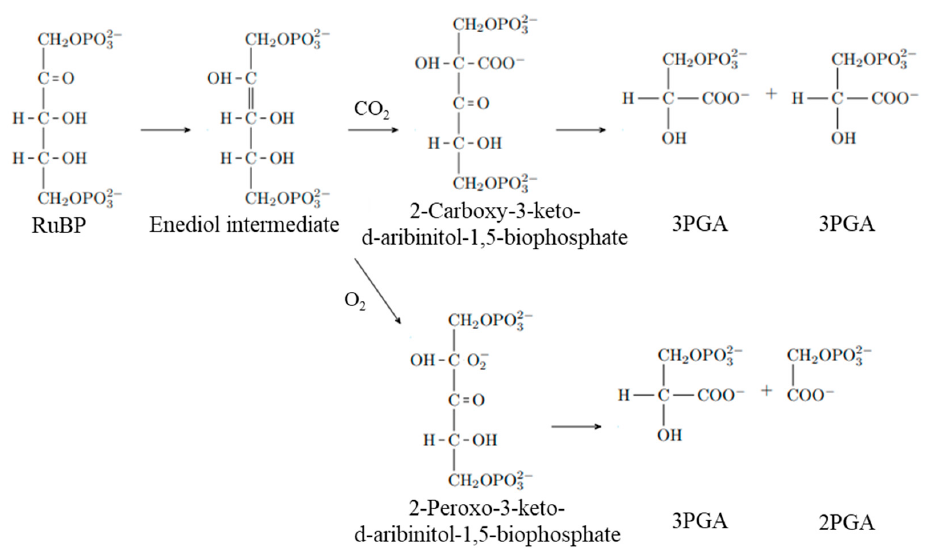
Figure 1. The carboxylation and oxygenation reactions of RuBisCO. RuBP reacts with CO 2 to form two molecules of 3PGA. Alternatively, RuBP reacts with O 2 to form one molecule of 3PGA and a molecule of 2PGA. RuBP, d-ribulose 1,5-bisphosphate; 3PGA, 3-phospho-d-glycerate; 2PGA, 2-phosphoglycolate. RuBisCO catalysis occurs at the interface of two large (L) subunits (LSU; ~50–52 kDa)